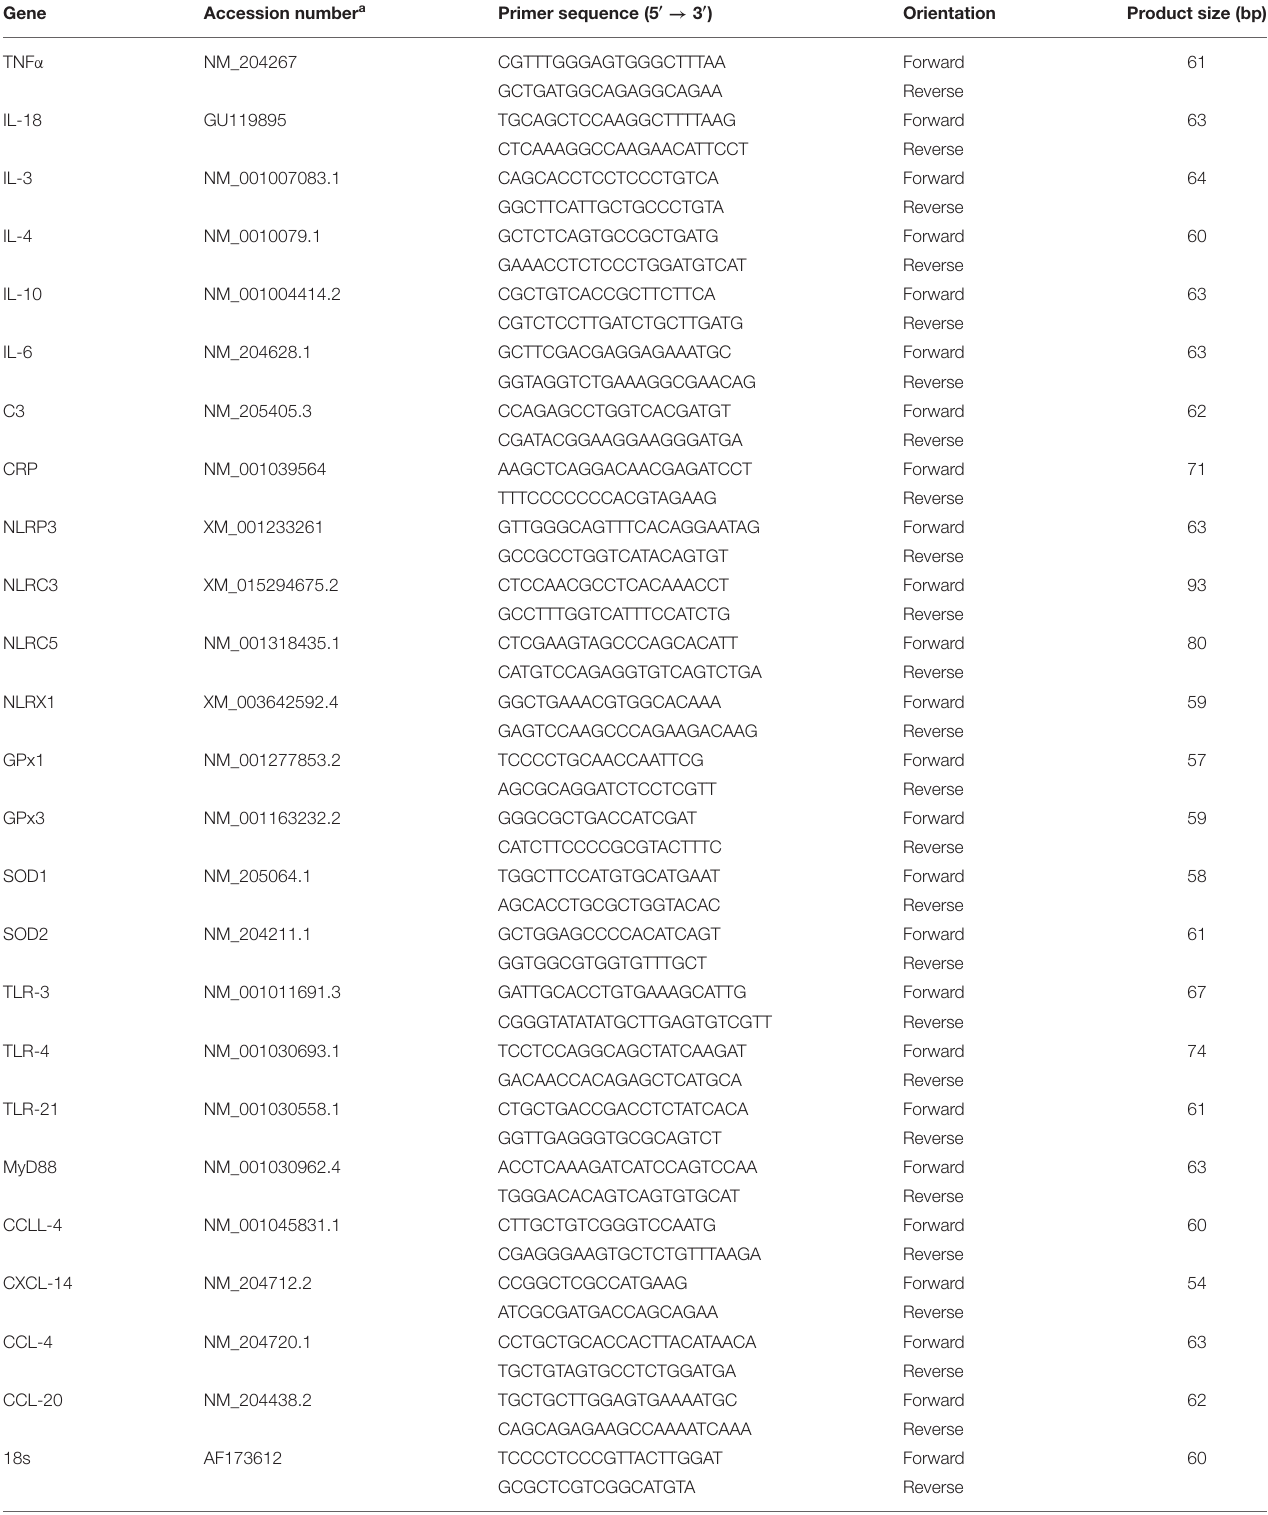
TABLE 2 | Oligonucleotide real-time qPCR primers.